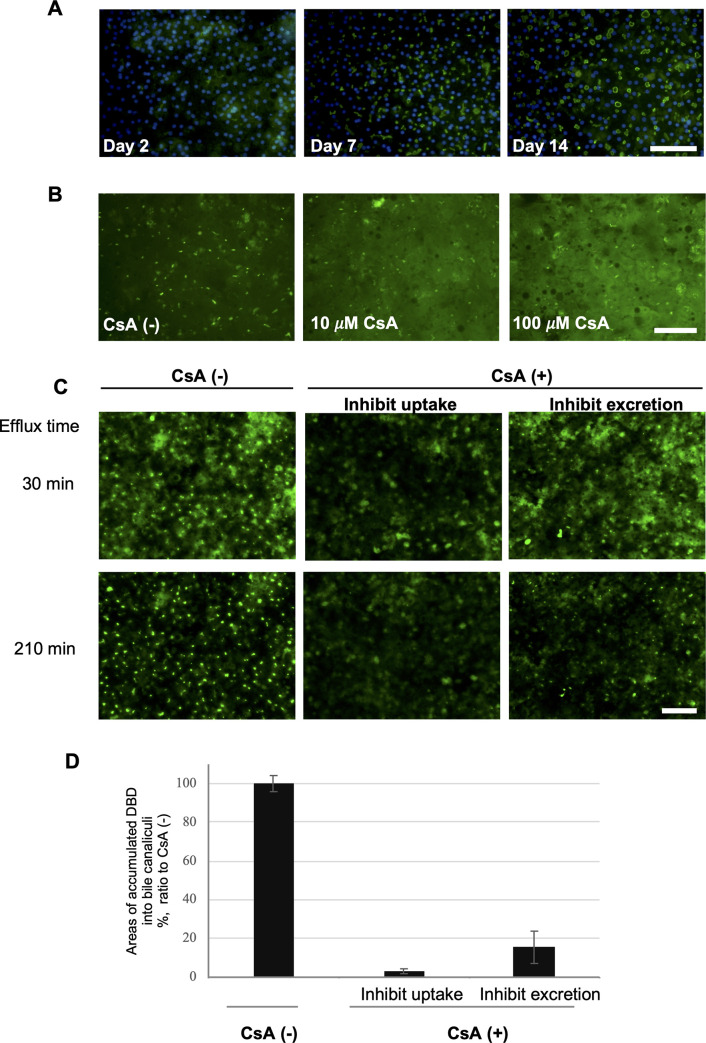
Expression and function of transporters in cFHHs during culture.A: Transporter protein localization and activity in cultured cFHHs. cFHHs (donor A) were plated at 2.13 × 105 cells/cm2. cFHHs were cultured for 7 and 14 days and fixed, and MRP2 protein expression was determined by immunostaining. Images of cFHHs after double staining with MRP2 (green) and Hoechst (blue) are presented. Scale bar denotes 100 μm. B: MRP2 transporter activity was determined in cultured cFHHs using CDFDA. cFHHs were incubated with CDFDA and CsA (10 or 100 μM) at day 7. CsA treatment inhibited the accumulation of CDF in the bile canaliculi, and intense fluorescence signals were observed in the cytoplasm at 10 and 100 μM CsA. Scale bar denotes 100 μm. C: NTCP and BSEP transporter activities were determined in cultured cFHHs using DBD and CsA. DBD was incorporated into cFHHs and accumulated in bile canaliculi between cFHHs at day 9, as shown in green. To inhibit uptake of the substrate by NTCP, cells were treated with CsA from the preincubation process onwards, before DBD treatment. To inhibit excretion of the substrate by BSEP, cells were treated with CsA from the washing process onwards, after DBD treatment. Scale bar denotes 100 μm. Effect of CsA treatment on DBD-uptake in cells via NTCP, and DBD-excretion in bile canaliculi via BSEP. D: Photographs of microscopy images were taken at 210 min and areas of DBD accumulation in bile canaliculi were measured using a Bz-X analyzer. DBD that had accumulated in bile canaliculi was expressed as a ratio with the control (CsA [–]).